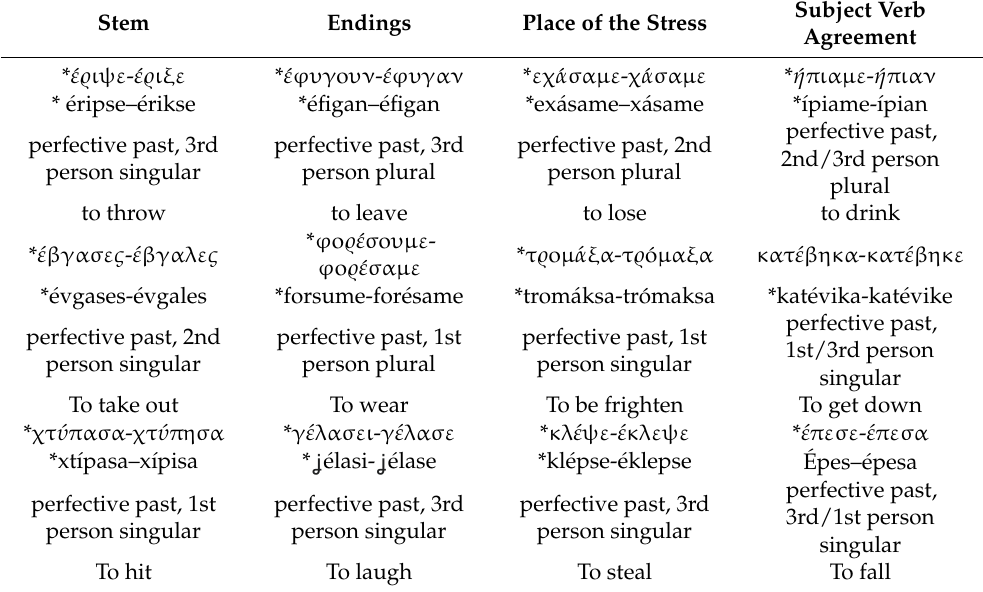
Table 1. The items Introduced in the GJT.